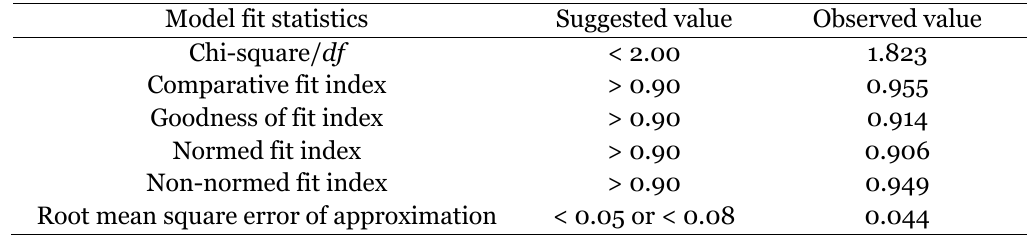
Summary of Model Fit Statistics for Structural